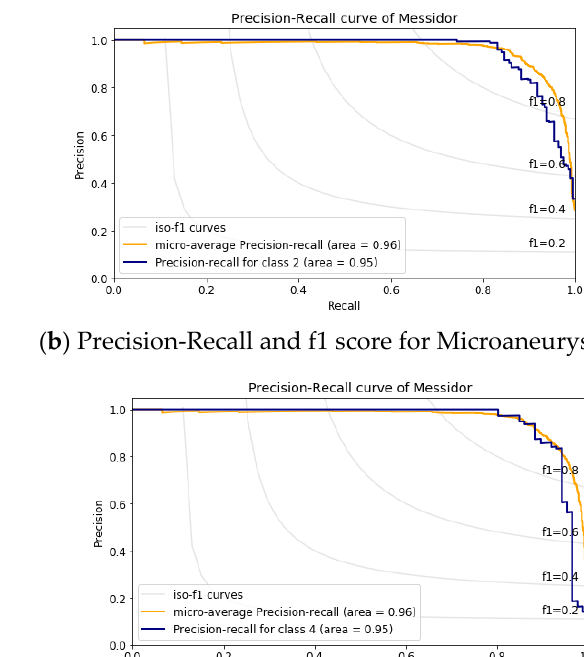
Figure 8. ROC analysis for the MESSIDOR dataset.